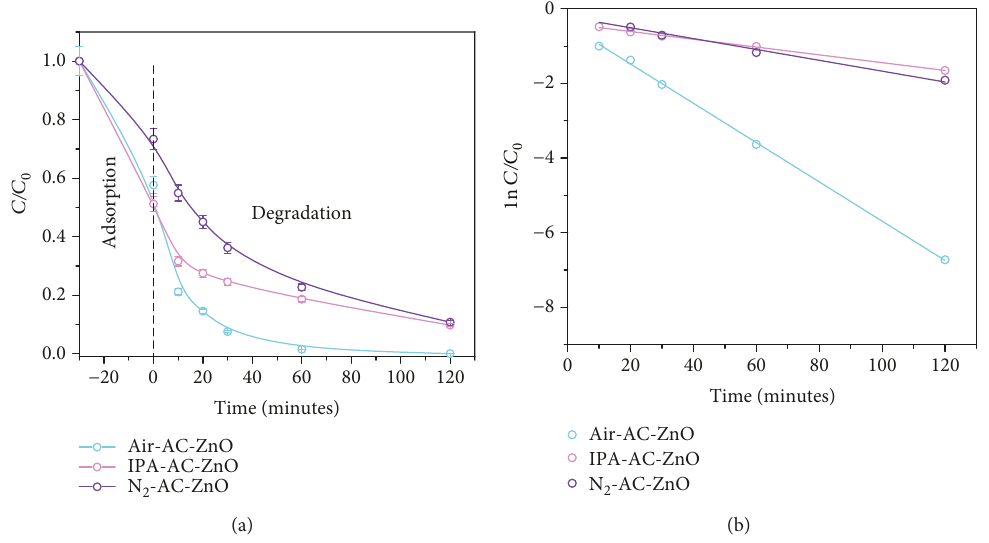
Figure 10: Plot of (a) C / C